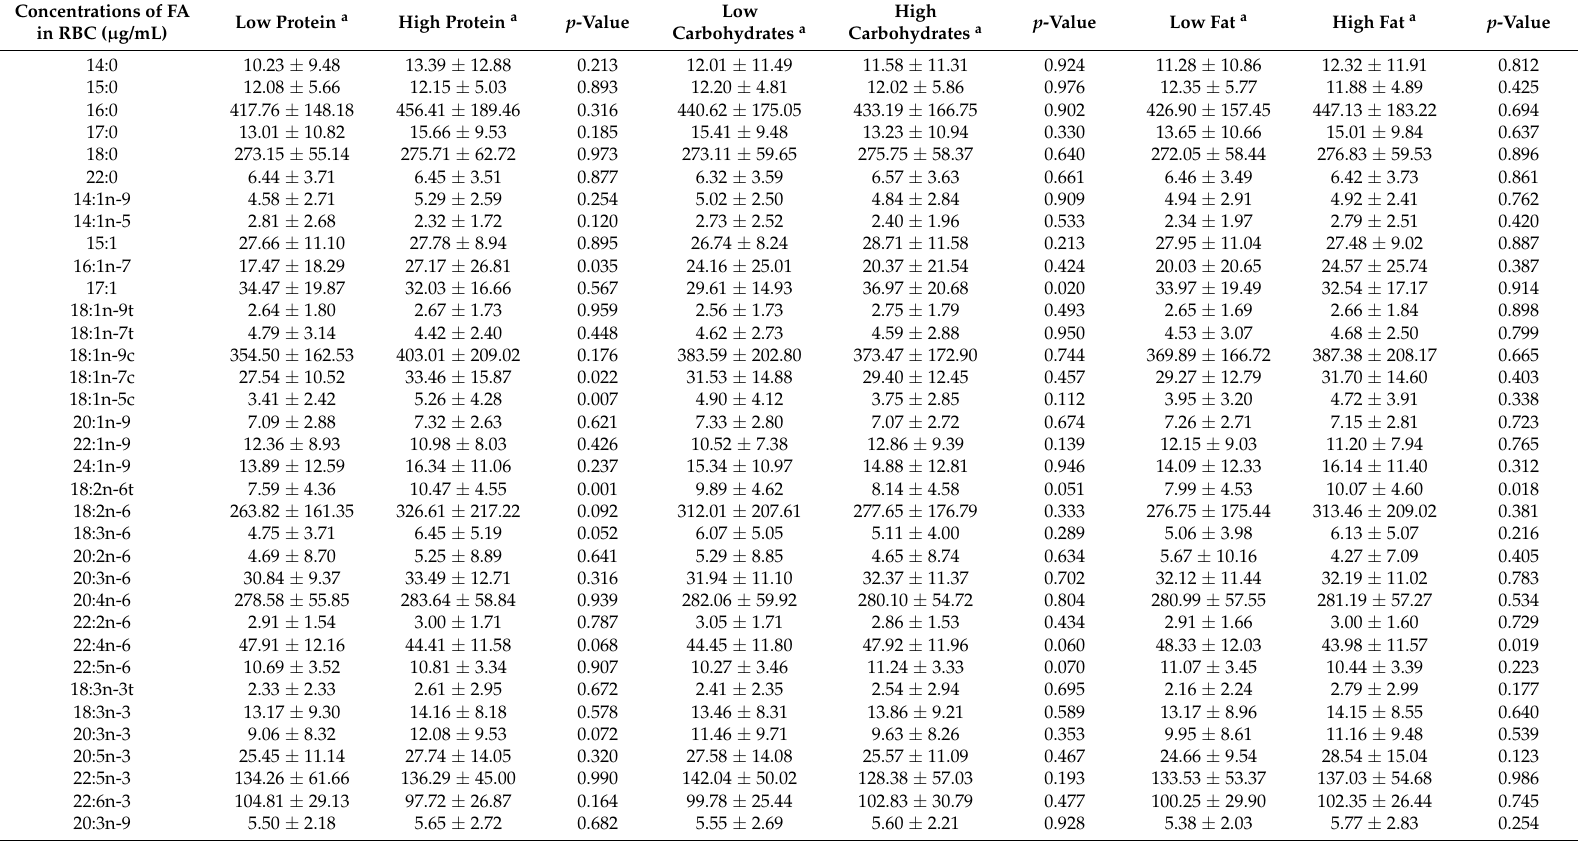
Table 3. Concentrations of erythrocyte fatty acids stratified by macronutrient